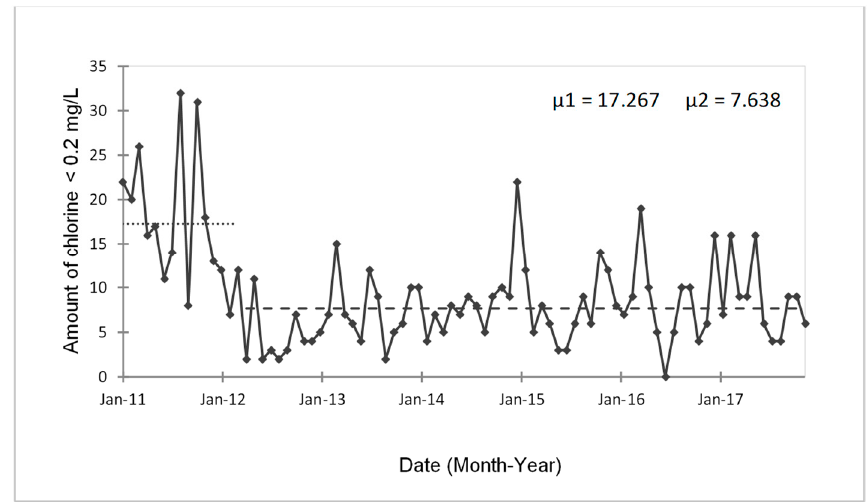
Figure 6. City of Salta. Pettit analysis for residual chlorine values. Significant shifts in mean values from Pettit analysis are indicated by (dotted line) and µ2 (dashed line).